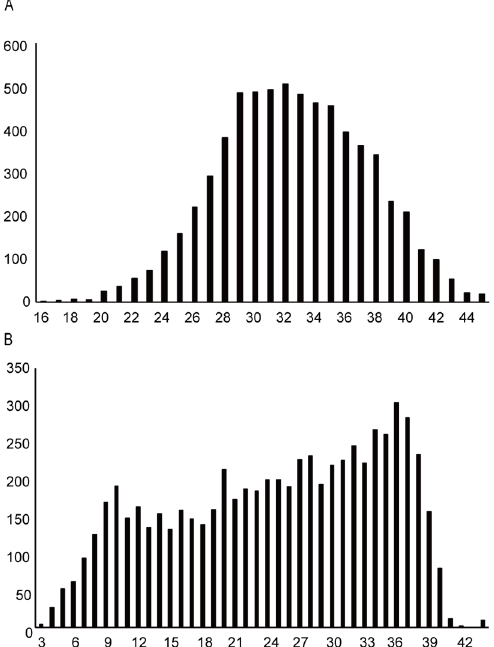
Figure 2. The distribution of age ( A ) and gestational weeks ( B ) of the participants.